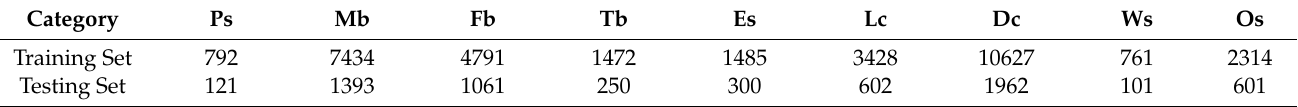
In Table 1: passenger ship, Ps; motorboat, Mb; fishing boat, Fb; tugboat, Tb; engineering ship, Es; Table 1. Number of ships in training set and test set. liquid cargo ship, Lc; dry cargo ship, Dc; war ship, Ws; other ship, Os.